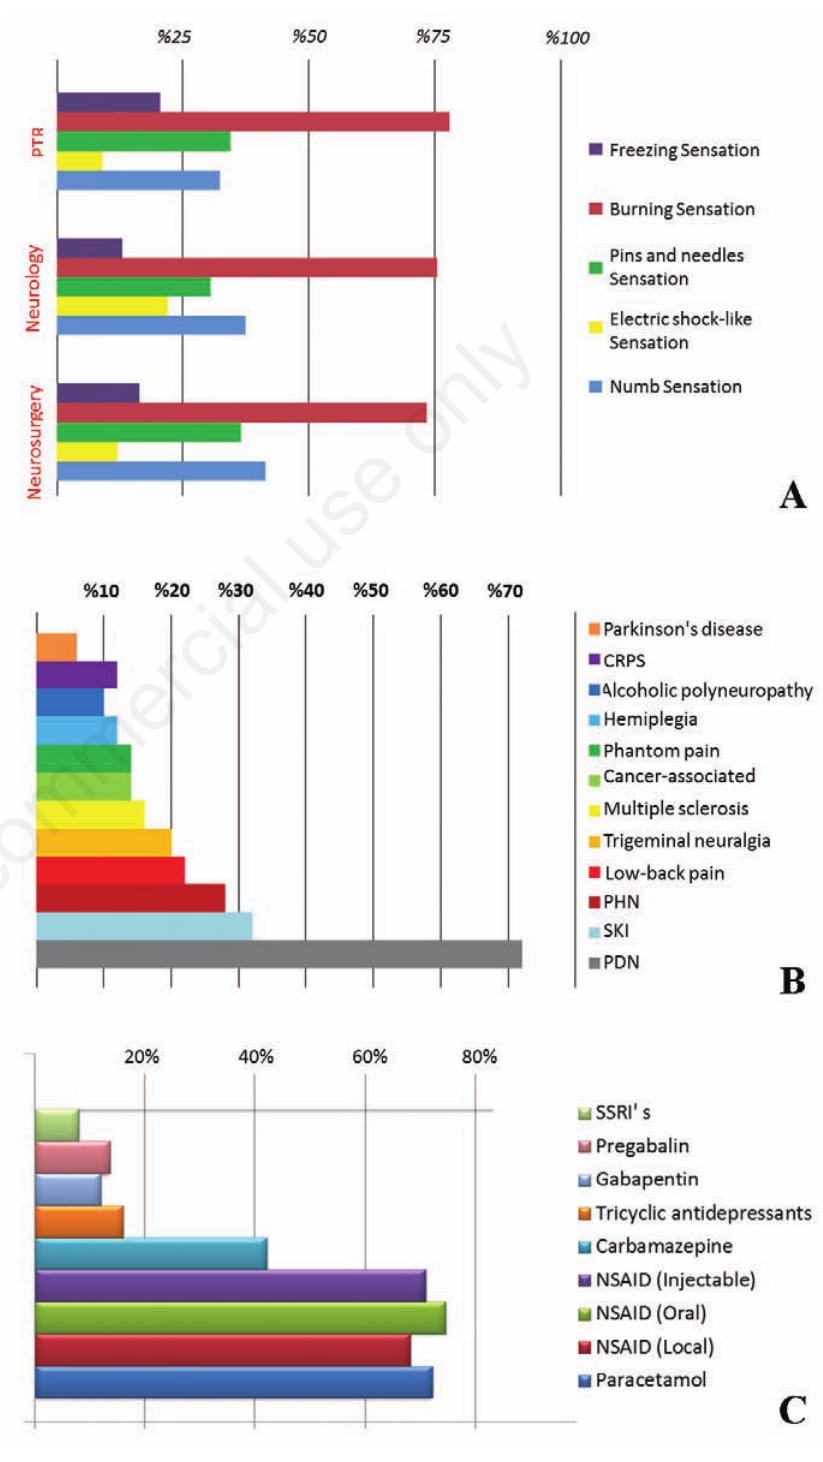
Figure 2. Percentage of knowledge about A) symptoms of neuropathic pain, B) neuro- pathic pain associated diseases, C) neuropathic pain